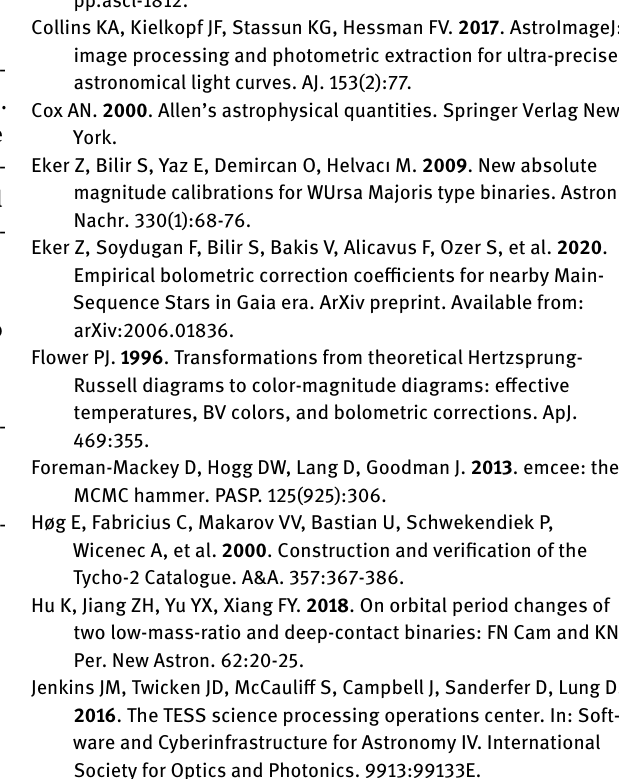
we expect it will become a deeper contact binary based on system